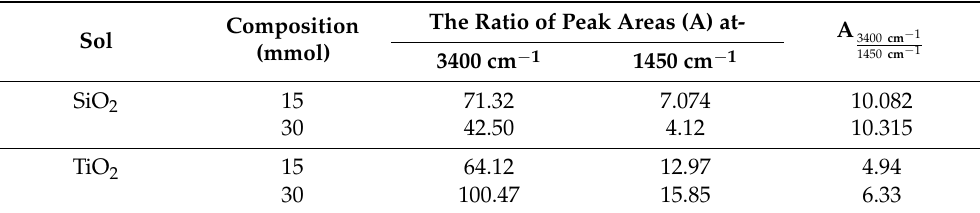
Figure 4. The FTIR images of SiO 2 -TiO 2 -OTMS coatings prepared with various compositions of ( a ) SiO 2 and ( b ) TiO 2 . Table 2. The ratio of peak areas of O-H to C-H vibration at 3400 and 1450 cm − 1 from FTIR spectra of SiO 2 -TiO 2 -OTMS samples with various compositions of SiO 2 and TiO 2